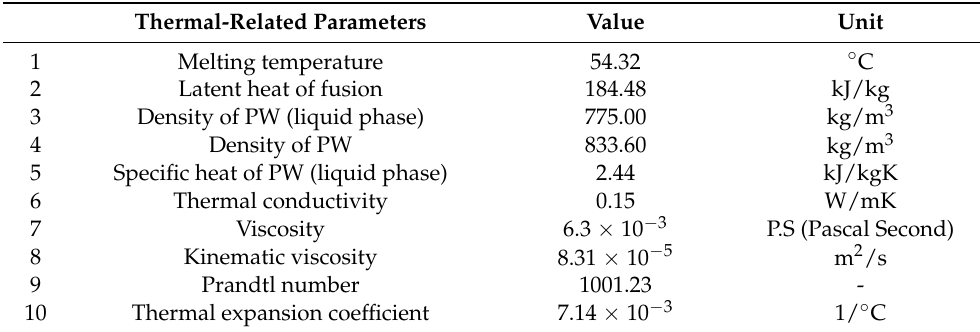
Table 1. Physical properties of the paraffin wax (PW) [5].